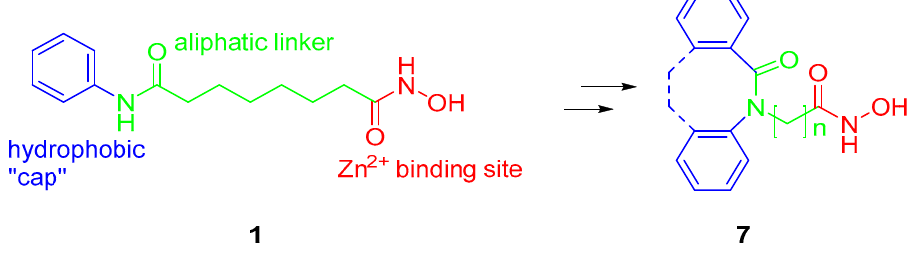
6 Figure 1. Vorinostat ( 1 ) and its analogues 2 – 6 based on benzodiazepine scaffolds. For years, our research group has been working on the design and synthesis